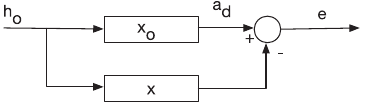
Figure 5. Adaptive process to determine the unknown excitation x ( n ).